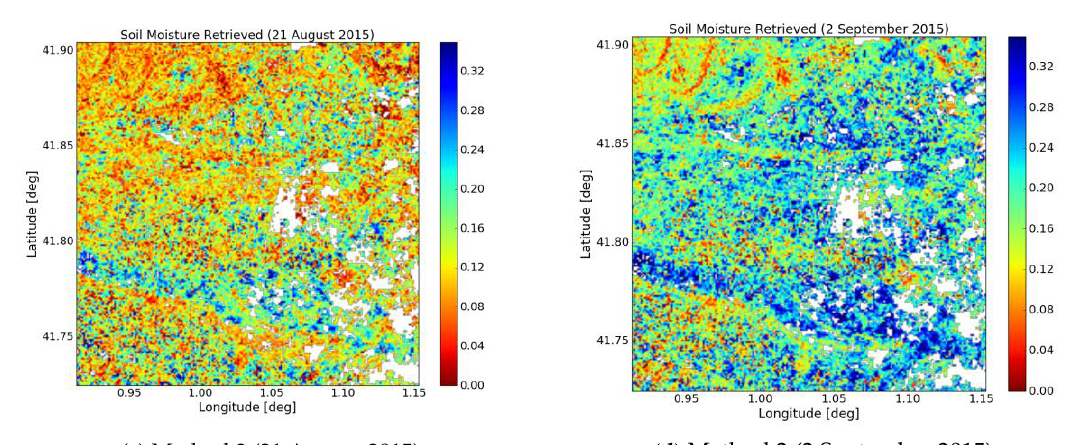
Figure 12. Retrieved soil moisture maps obtained using methods 1 and 2.